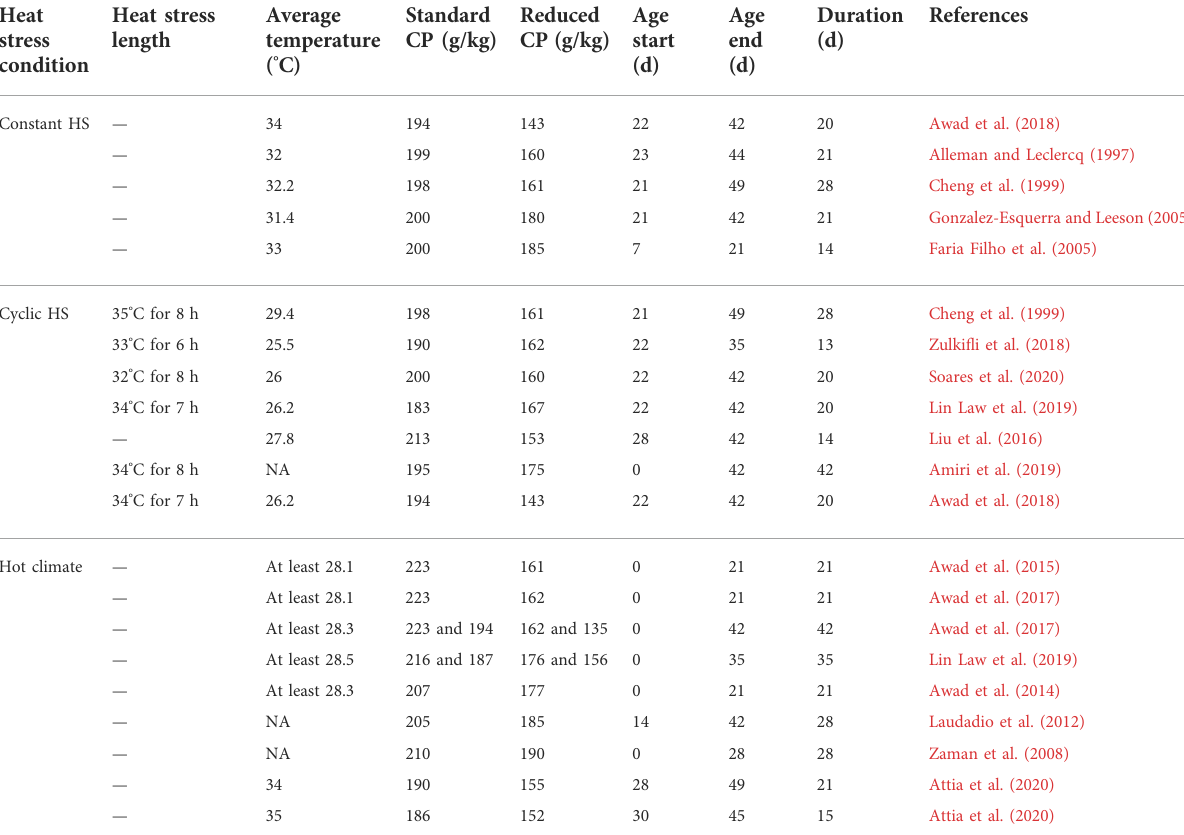
TABLE 1 Summary of experimental conditions of broiler studies comparing reduced and standard CP diets under HS